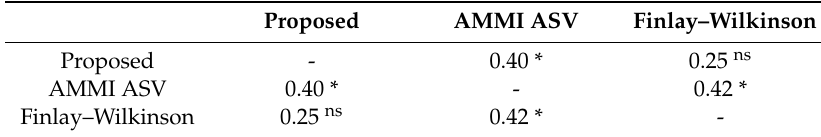
Table6. Spearman’srankcorrelationcoe ffi